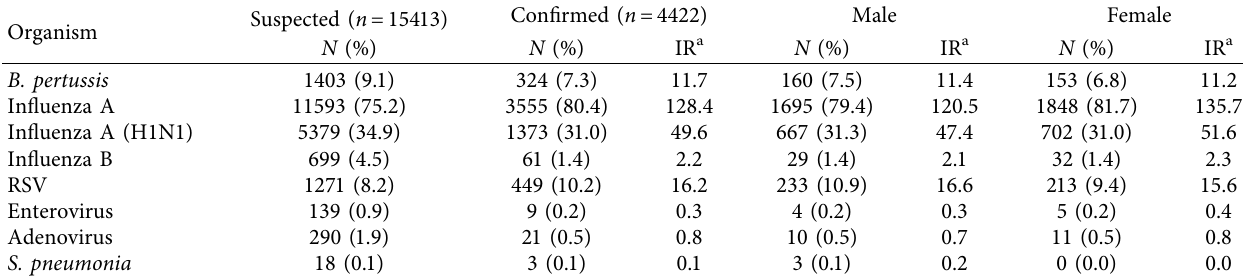
Table 2: Frequency and incidence rates of confirmed respiratory tract infection-related hospitalization stratified by gender. Organism